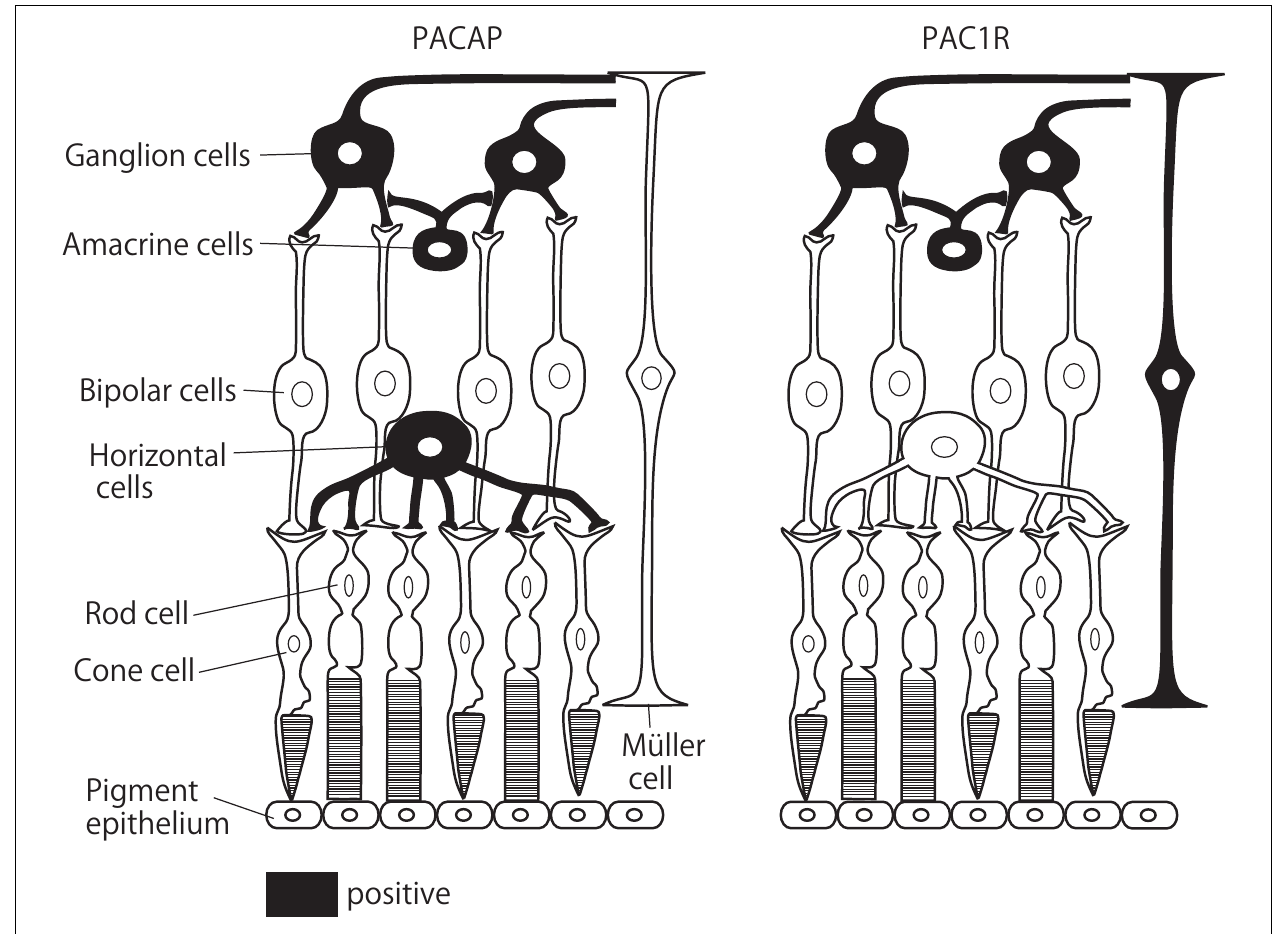
FIGURE 1 | Schematic diagram of PACAP and PAC1R distributions in the rodent retina. Black color indicates PACAP or PAC1R-expressing cells according to previous reports.